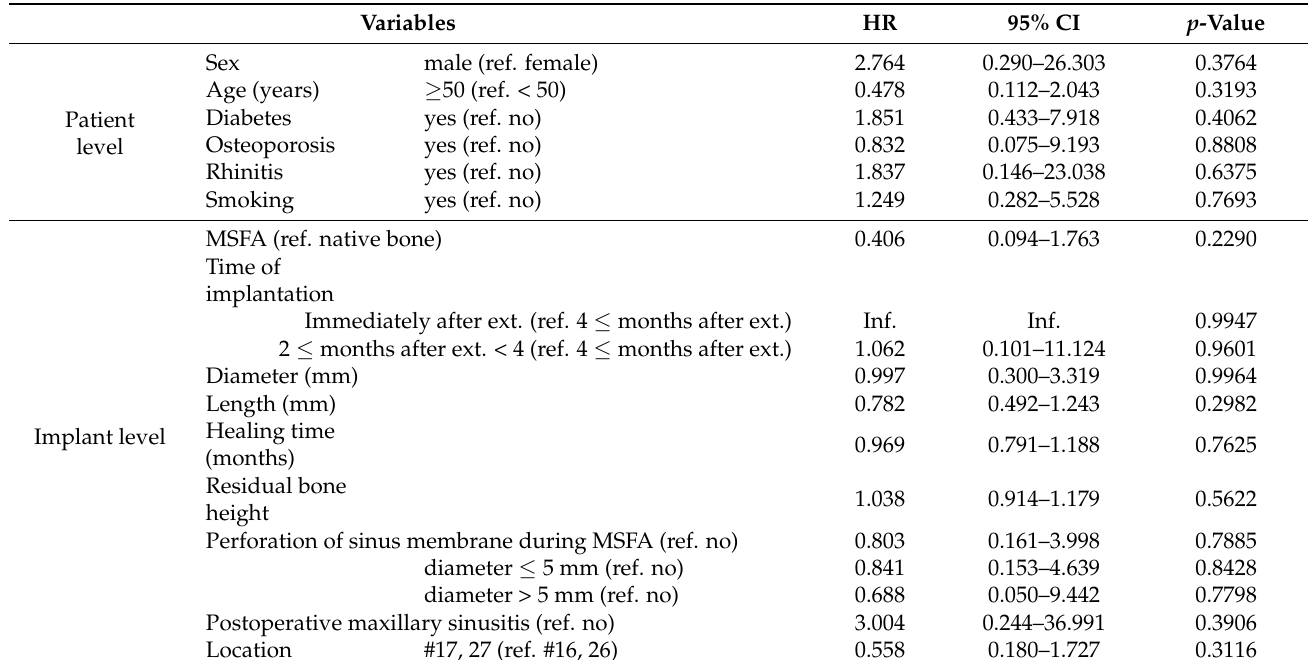
Table 2. Univariable analysis using a frailty model for implant failure.